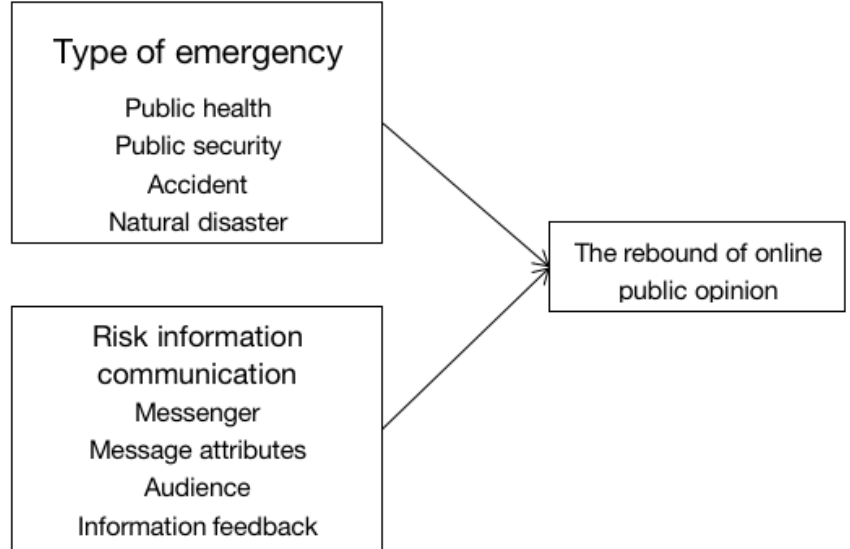
Figure 2. Influence-factor model of the rebound of online public opinion in emergencies.